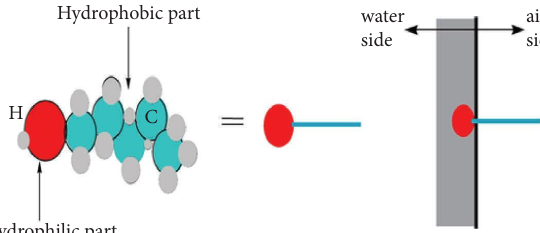
Figure 3: Interaction of frother with graphite and hydrophilic and hydrophobic